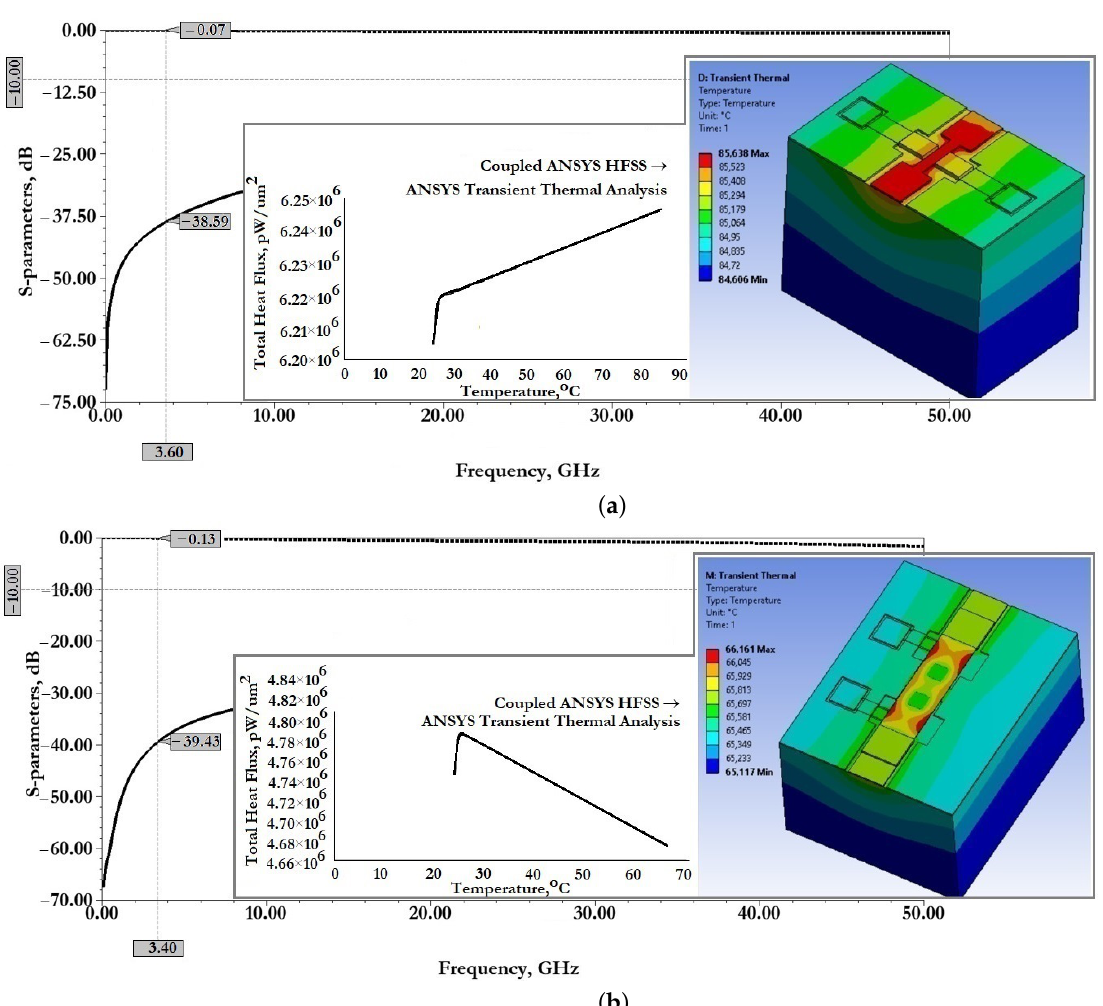
Figure 15. The results of EM and transient thermal modeling of CPW (A) and CPW (B) including fixed down actuation electrodes, contact pads and contact lines: ( a ) switch (A); ( b ) switch